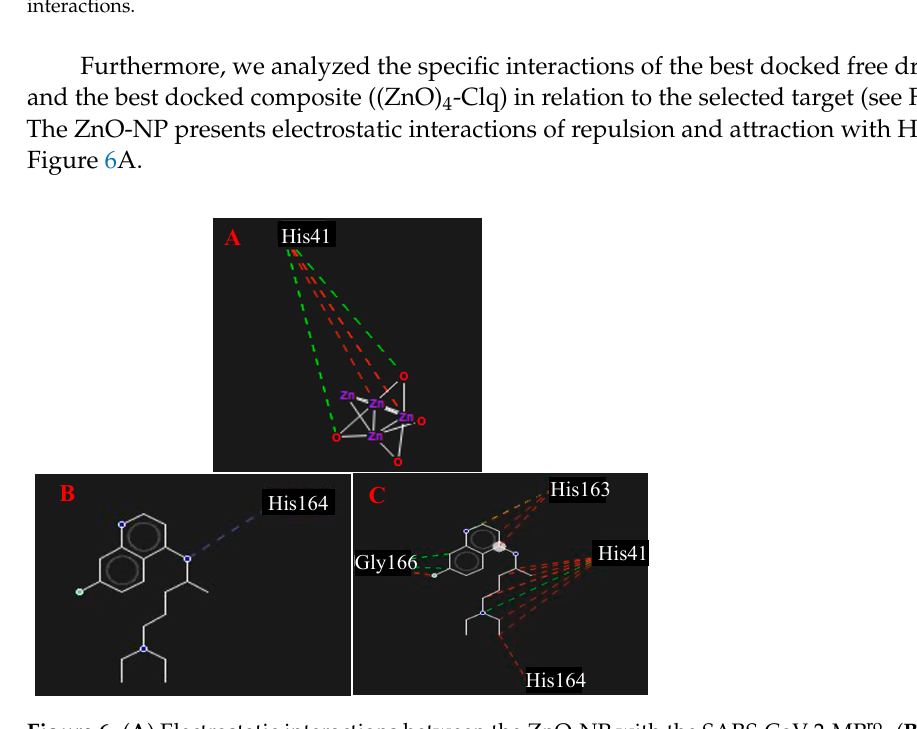
Figure 6. ( A ) Electrostatic interactions between the ZnO-NP with the SARS-CoV-2-MP ro . ( B ) H-bond and ( C ) electrostatic interactions between Clq and the selected target. Green and red lines are the attraction and repulsion electrostatic interactions, respectively, and blue lines depicts the H-bond interactions.